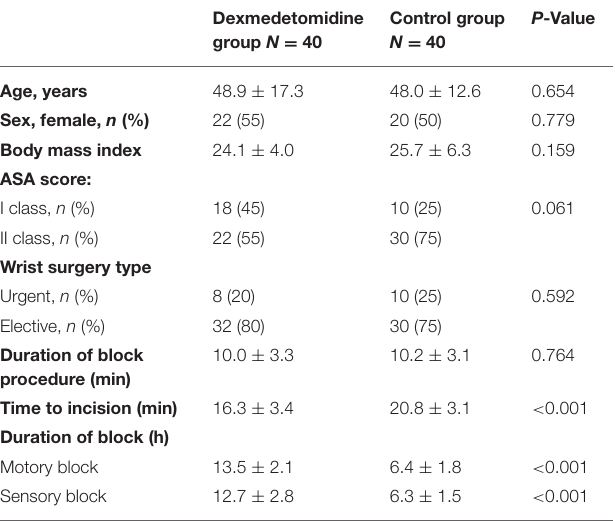
TABLE 1 | Demographic and clinical course characteristics of patients scheduled for wrist surgery undergoing axillary brachial plexus block.